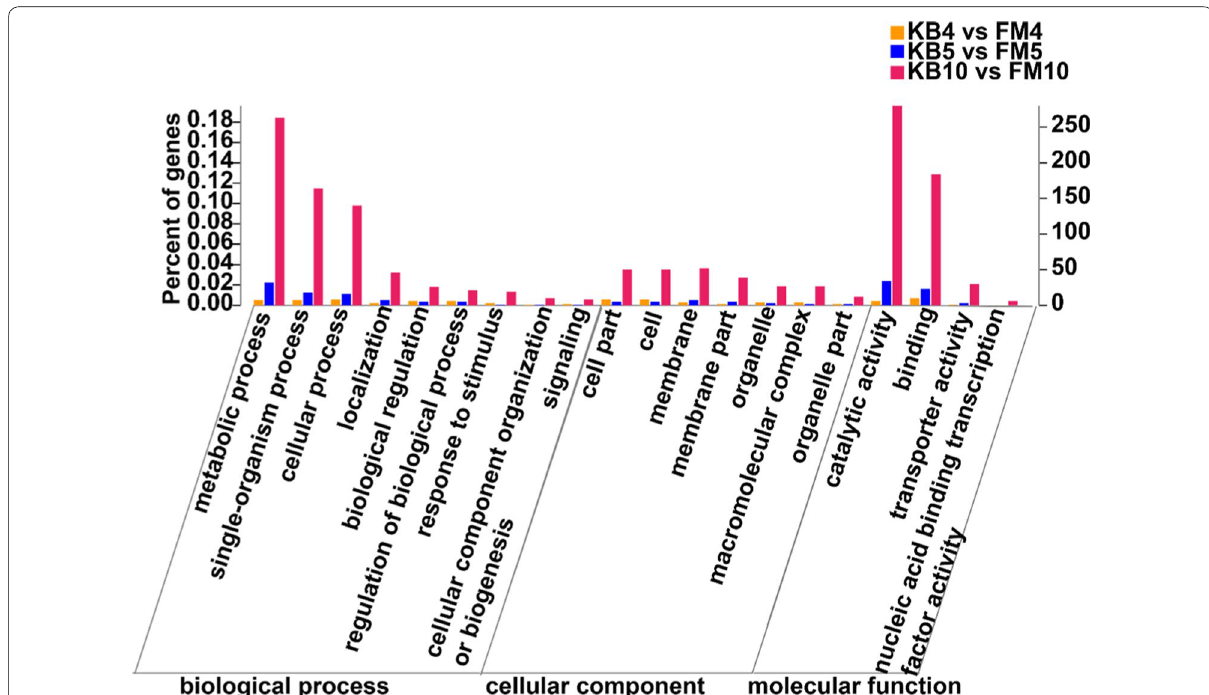
Fig. 2 GO annotation of DEGs. Each bar represent the percentage and number of genes in each GO category. Yellow, blue, and red colouring represent DEGs on days 4, 5, and 10,